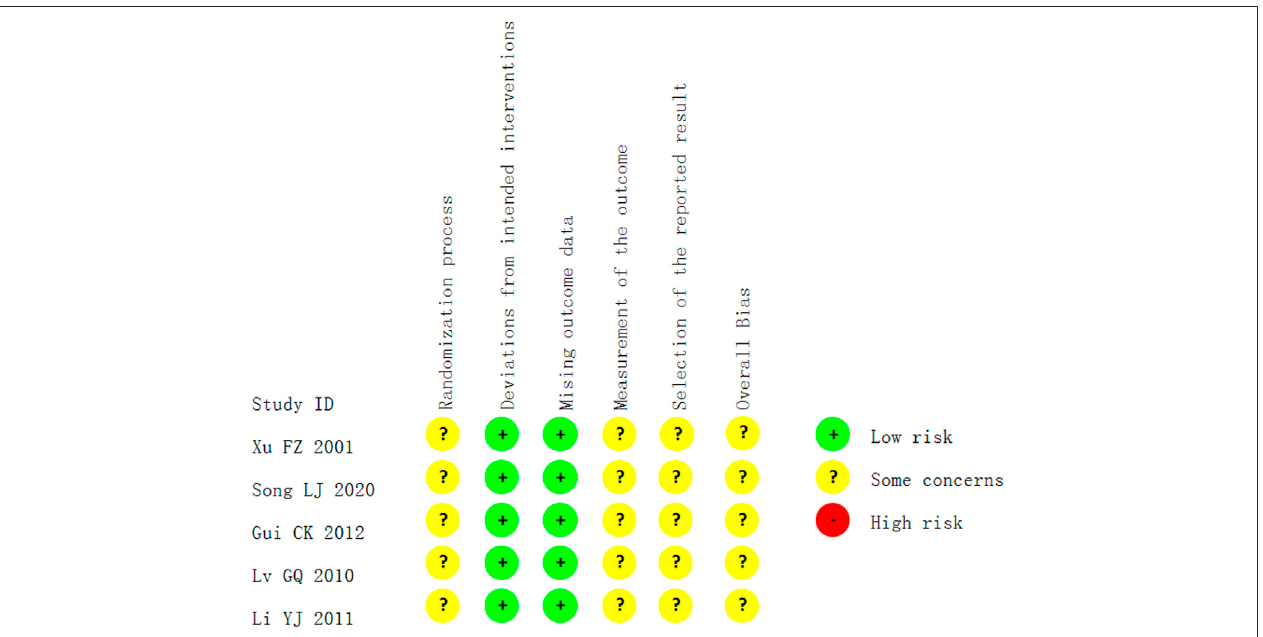
FIGURE 2 | Risk of bias in the studies which reported the outcome of